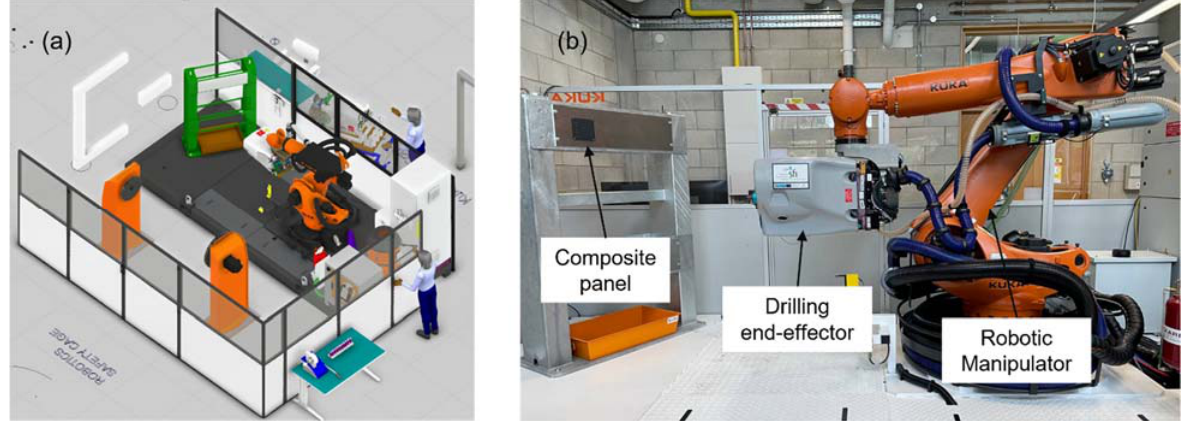
Figure 6. Manufacturing cell for robotic drilling ( a ) 3D CAD model, ( b ) physical space at University of Limerick, Confirm Smart Manufacturing laboratory.